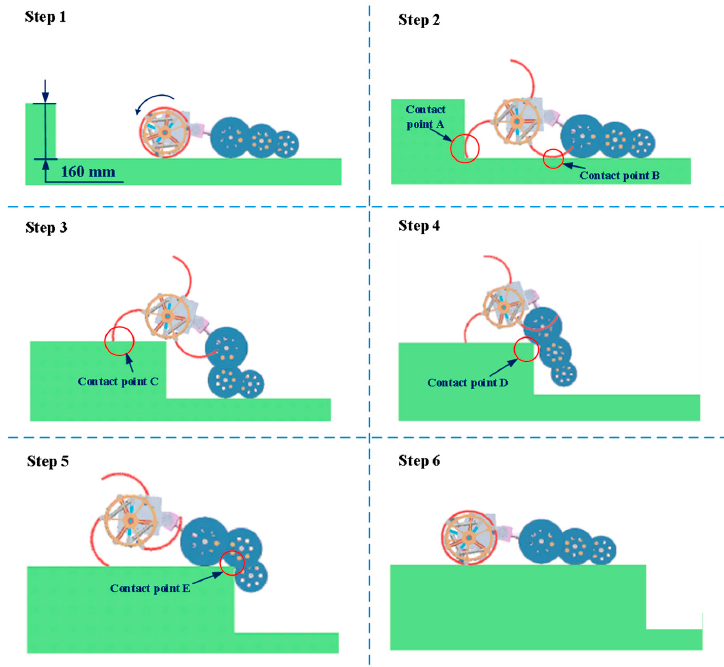
Figure 10. Moving over the vertical obstacle.